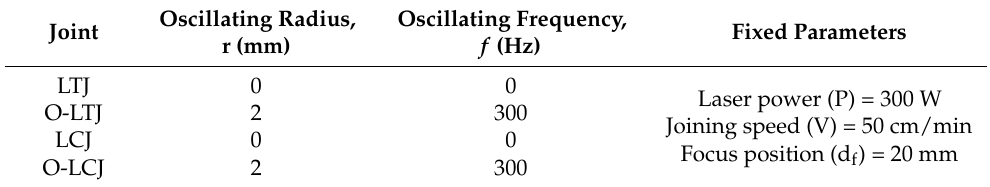
Table 2. Joining process